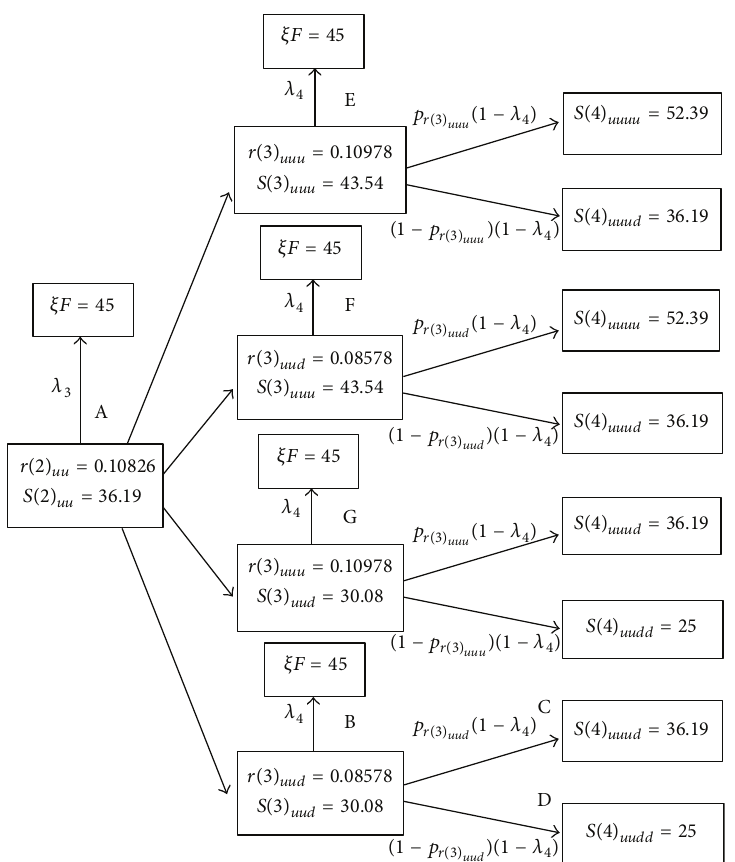
Figure 4: Constructing pricing tree under time-varying volatility interest rate